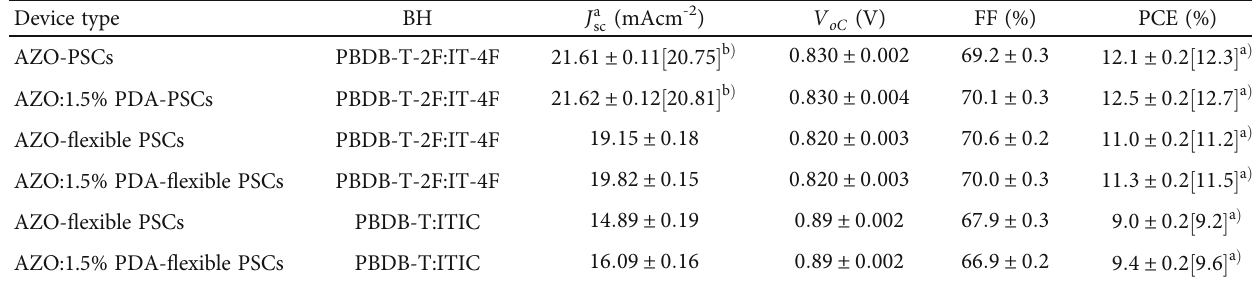
Table 1: Device properties of inverted PSCs with PBDB-T-2F and IT-4F layers. Device